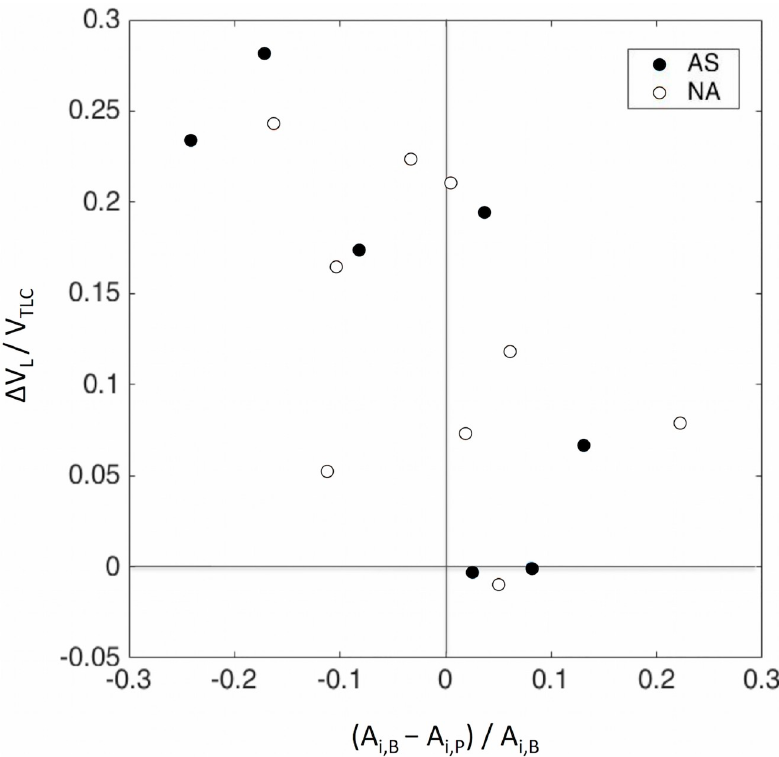
Fig 6. Measured values of Δ V for each subject vs . average change in luminal airway among segmental L /V TLC airways following MCh, for subjects with (AS, blue) and without (NA, red) asthma. Although it was relatively weak, the negative association (R = -0.63, P < 0.01 for all subjects) between the variables indicates that subjects with the greatest relative reduction in average airway luminal cross-sectional area, (highest degree of narrowing), tended to be those with the lowest changes in lung volume Post MCh, or inversely: the subjects with greater increases in lung < 0. volume Post MCh tended to have an increase in average luminal airway or, ( A i , B -A i , P )/A i , B